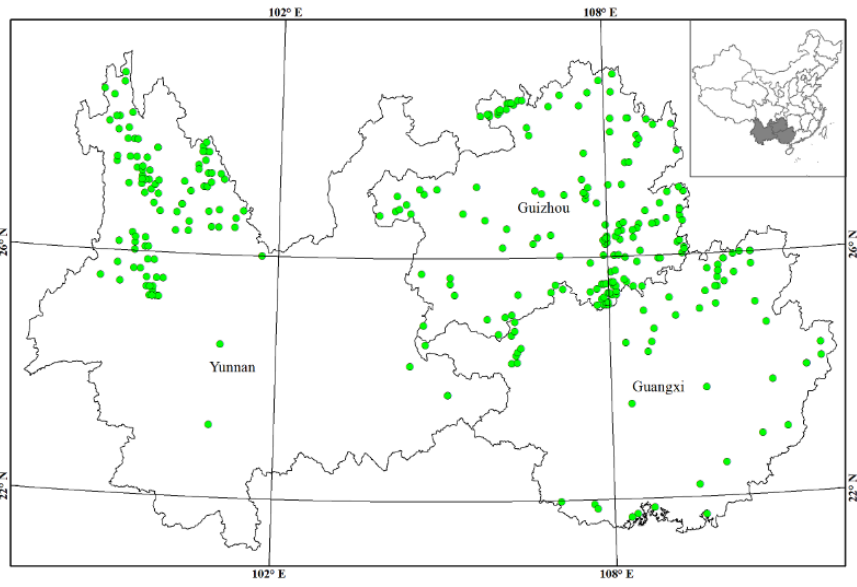
Figure 1. Locations of the 318 sampling plots across the southwest of China.